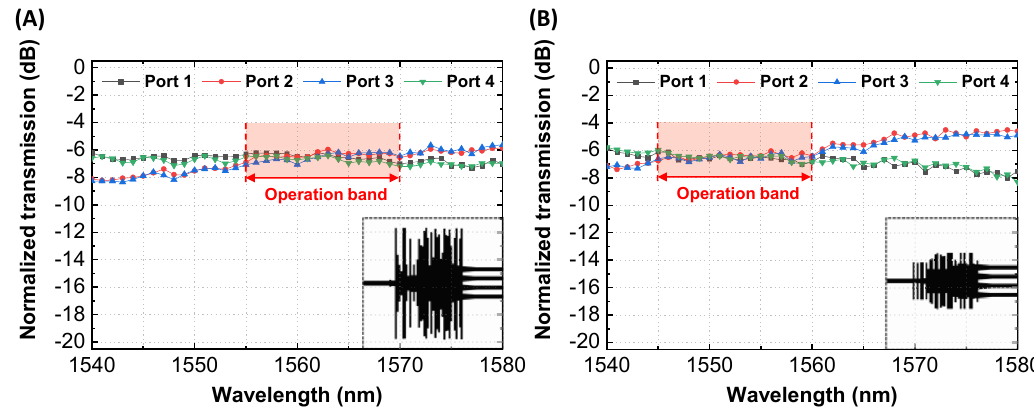
Figure 5: Measured transmission spectra of the fabricated 1 × 4 power splitters, (A) OPS 1 and (B) OPS